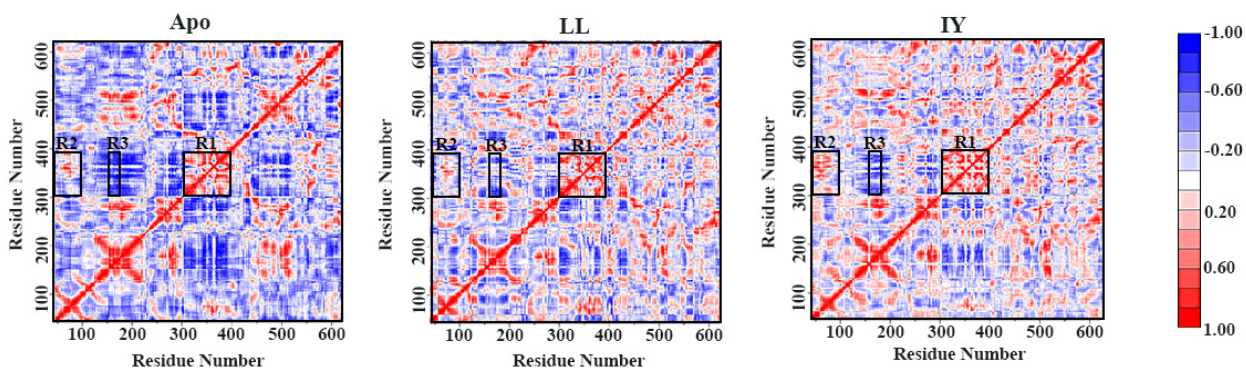
Figure 5. The dynamic cross-correlation map for the 1 µ s GaMD simulation trajectories of the three systems. The positive regions are colored in red, whereas the negative regions are shown in blue, representing correlated and anti-correlated motions between residue atoms, respectively. The Apo means ligand-free protein, LL represents the complex system of protein and dipeptide Leu-Leu, and IY stands for complex system of protein and dipeptide Ile-Tyr.